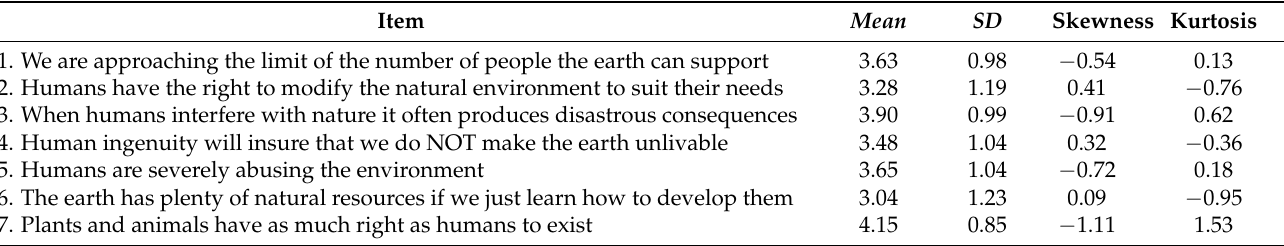
Table A9. Descriptive analysis of the New Ecological Paradigm ( n = 595, 2021